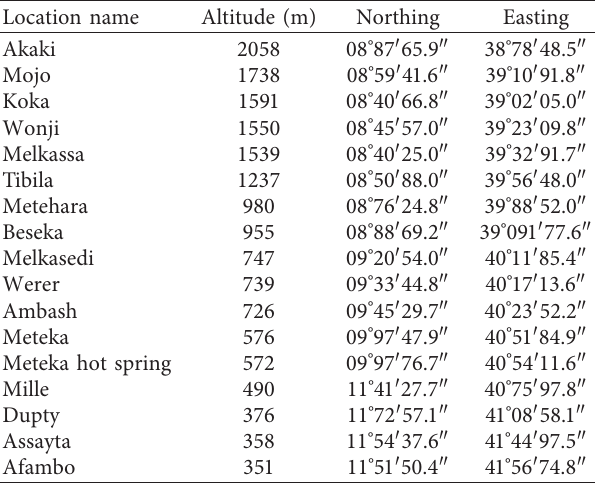
Table 1: Locations for sampling sites of the Awash River. Location